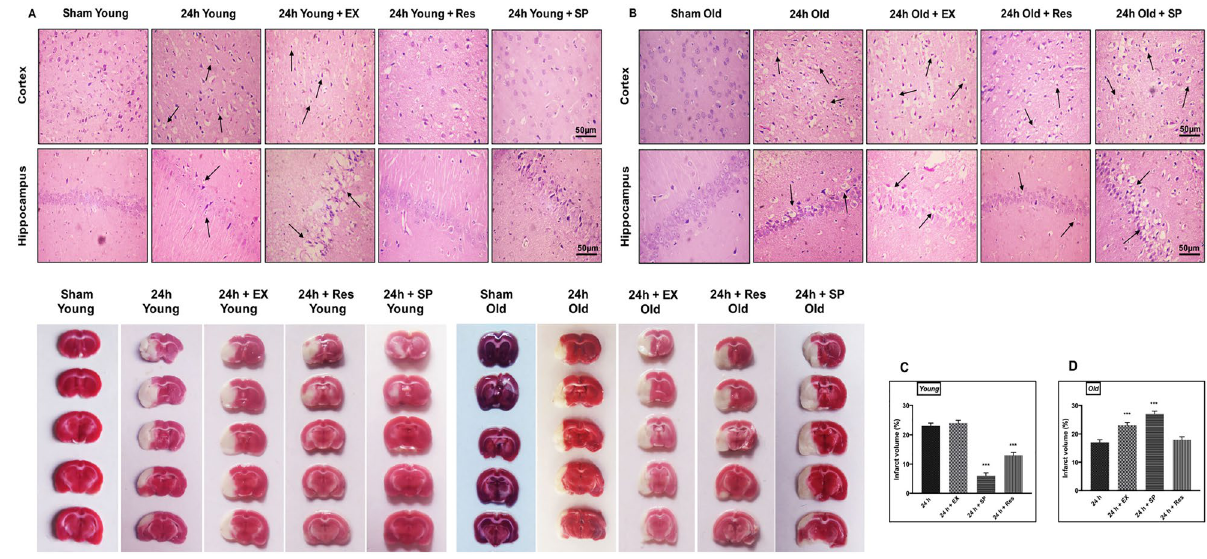
Figure 2. Assessment of morphological changes following CI. The morphological changes in cortex and hippocampus neurons were assessed using H&E staining (magnification 400X; Scale Bar—50 μm). (A) Representative H&E staining of paraffin-embedded brain sections from sham control, 24 h MCAO, MCAO + resveratrol, MCAO + EX-527, and MCAO + SP600125 treatment in young rats. Morphological changes were represented in black arrows (pyknotic neuron). Black arrow shows the presence of extensive changes in neuronal morphology in the brains of 24 h MCAO and EX-527 treatment, whereas pathological changes was decreased in resveratrol and Sp600125 treatment. (B) H&E staining of brain sections from sham control, 24 h MCAO, MCAO + resveratrol, MCAO + EX-527, and MCAO + SP600125 treatment in aged rats. Black arrow represents the presence of extensive changes in neuronal morphology in the brains of 24 h MCAO and EX-527 treatment, whereas SP600125 and resveratrol failed to reduce pathological changes. The infarct intensity was measured with TTC staining. (C) Resveratrol and SP600125 treatment decreased infarct volume and abolished the effect of EX-527 in the brains of young rat following MCAO. (D) In aged experimental rats EX-527 and SP600125 treatment increased infarct and resveratrol treatment failed to reduce infarct following MCAO. The data are presented as a percentage of tissue loss (n = 3). *p < 0.05 versus ischemic